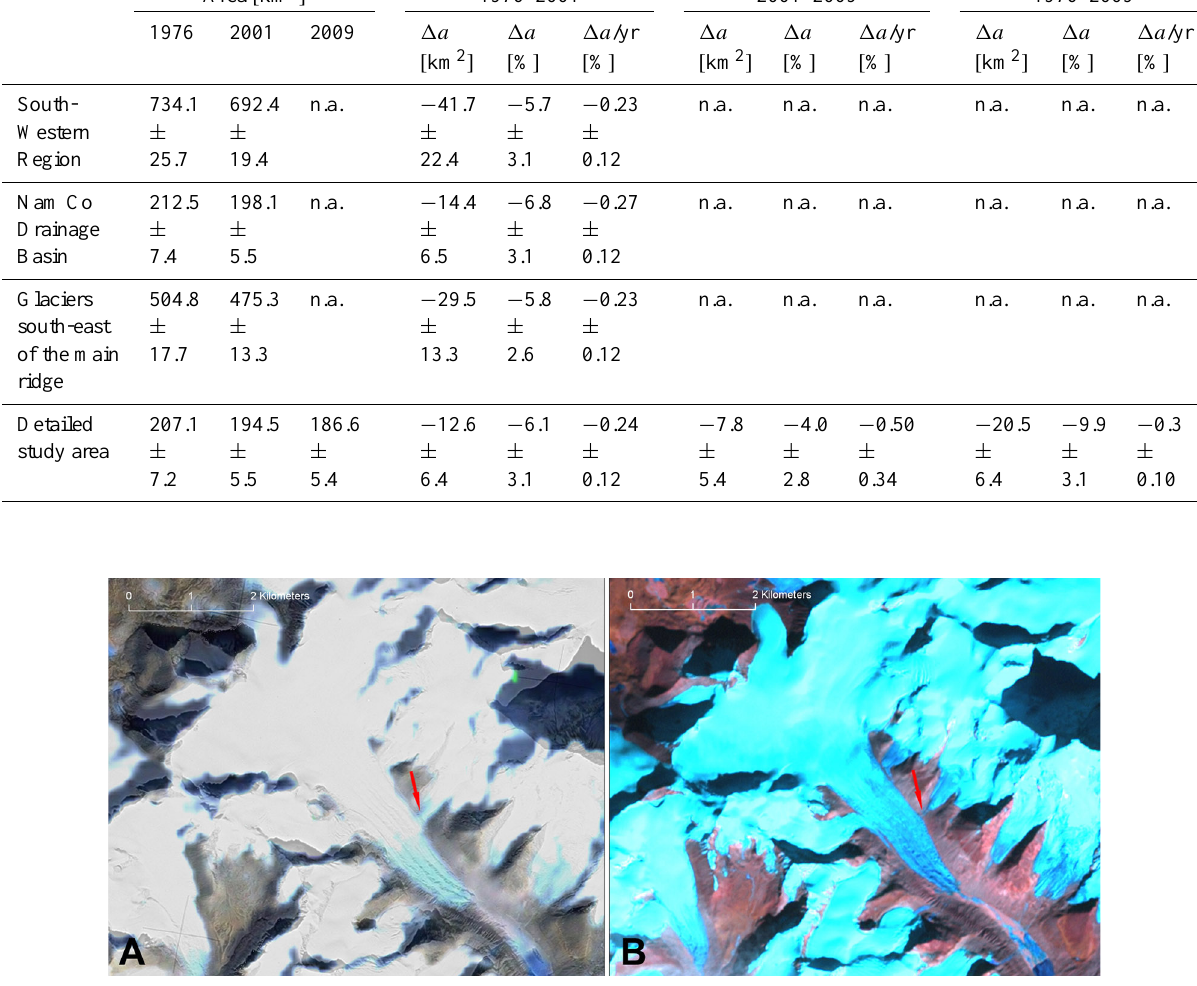
Fig. 10. Panu Glacier 1976 – merge of Landsat MSS and Hexagon (A) and 2001 – Landsat ETM+, 5-4-3-PAN (B) . The arrow indicates the separation of one tributary glacier between 1976 and